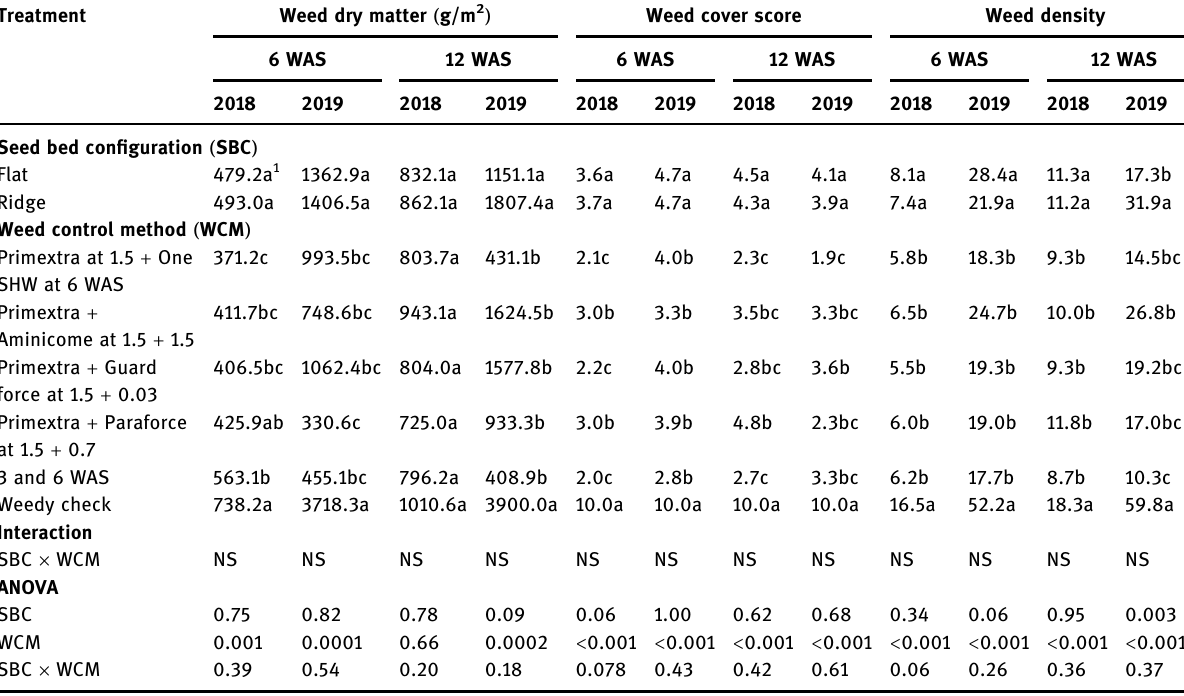
Table 2: E ff ect of seed bed con fi guration and weed control method on weed dry matter, weed cover, and weed density Treatment Weed dry matter ( g/m 2 ) Weed cover score Weed